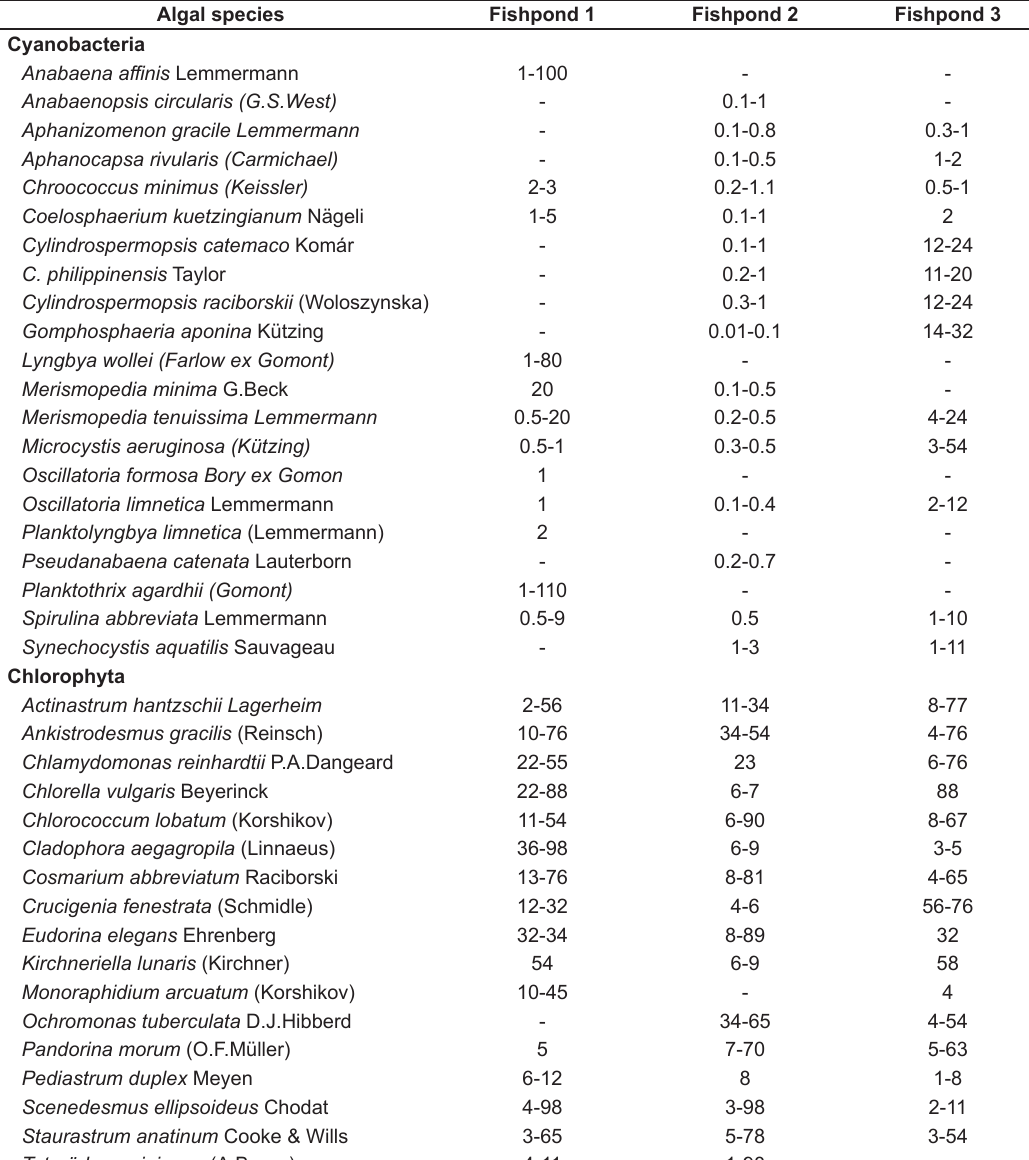
Table 1. Phytoplankton species composition ( cells x10 6 L -1 ) in fishponds used in the present study. Algal